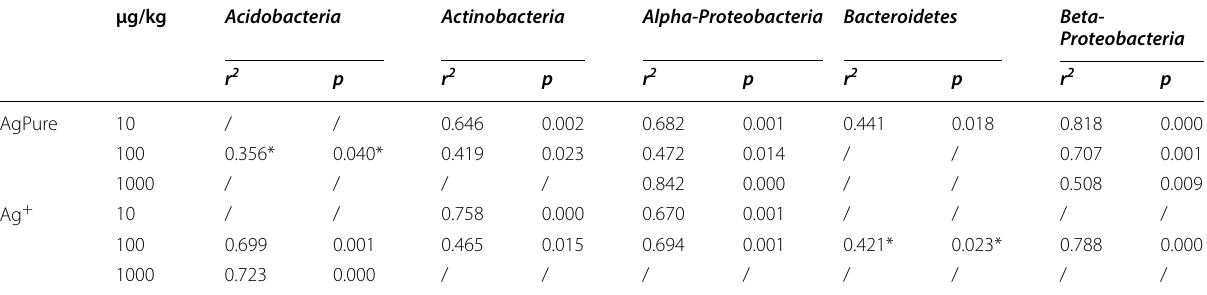
Negative correlations were marked by a star. In case of “/” no significant comparison could be